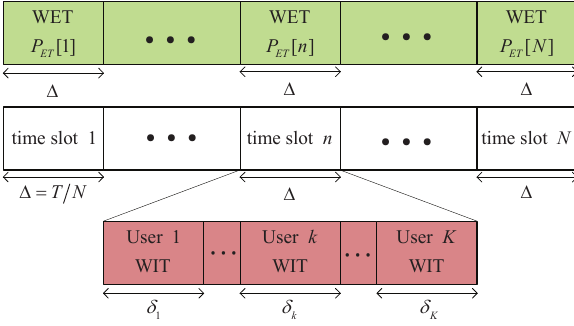
Figure 2. Communication protocol frame for Multi-UAV-Enabled